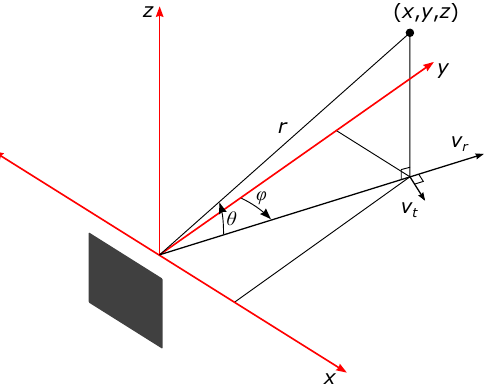
Figure 9. Representation of a single point of reflection in the sensor’s coordinate system. Distances x , y and z describe point’s position in radar’s Cartesian space; radius r , elevation angle θ and azimuth angle ϕ describe point’s position in spherical coordinates; point’s radial velocity is represented by v r , and tangential velocity is represented by v t (the latter is not measured by the